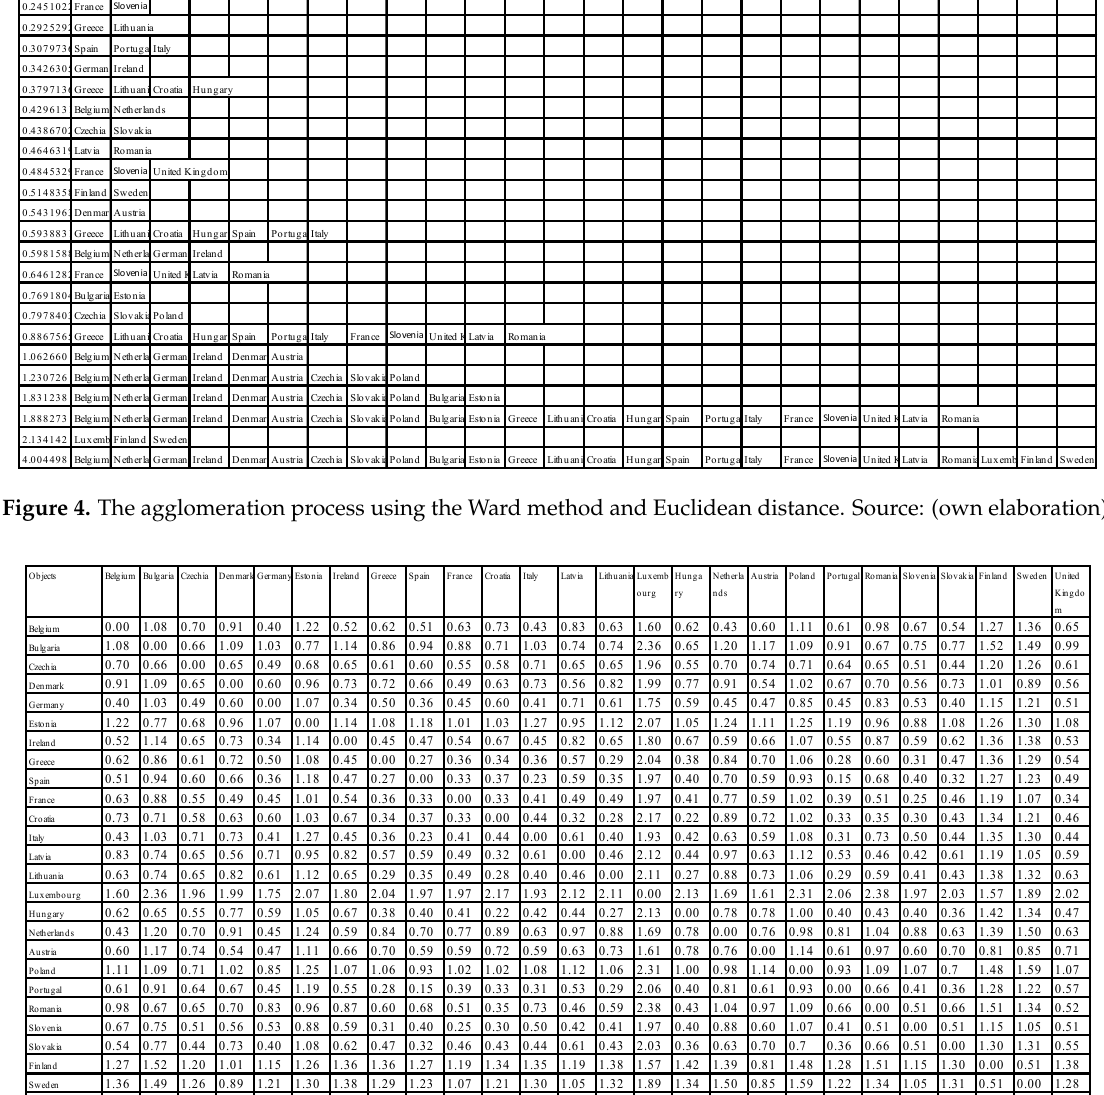
Figure 6. Binding distances relative to the binding stages . Source: (own elaboration).